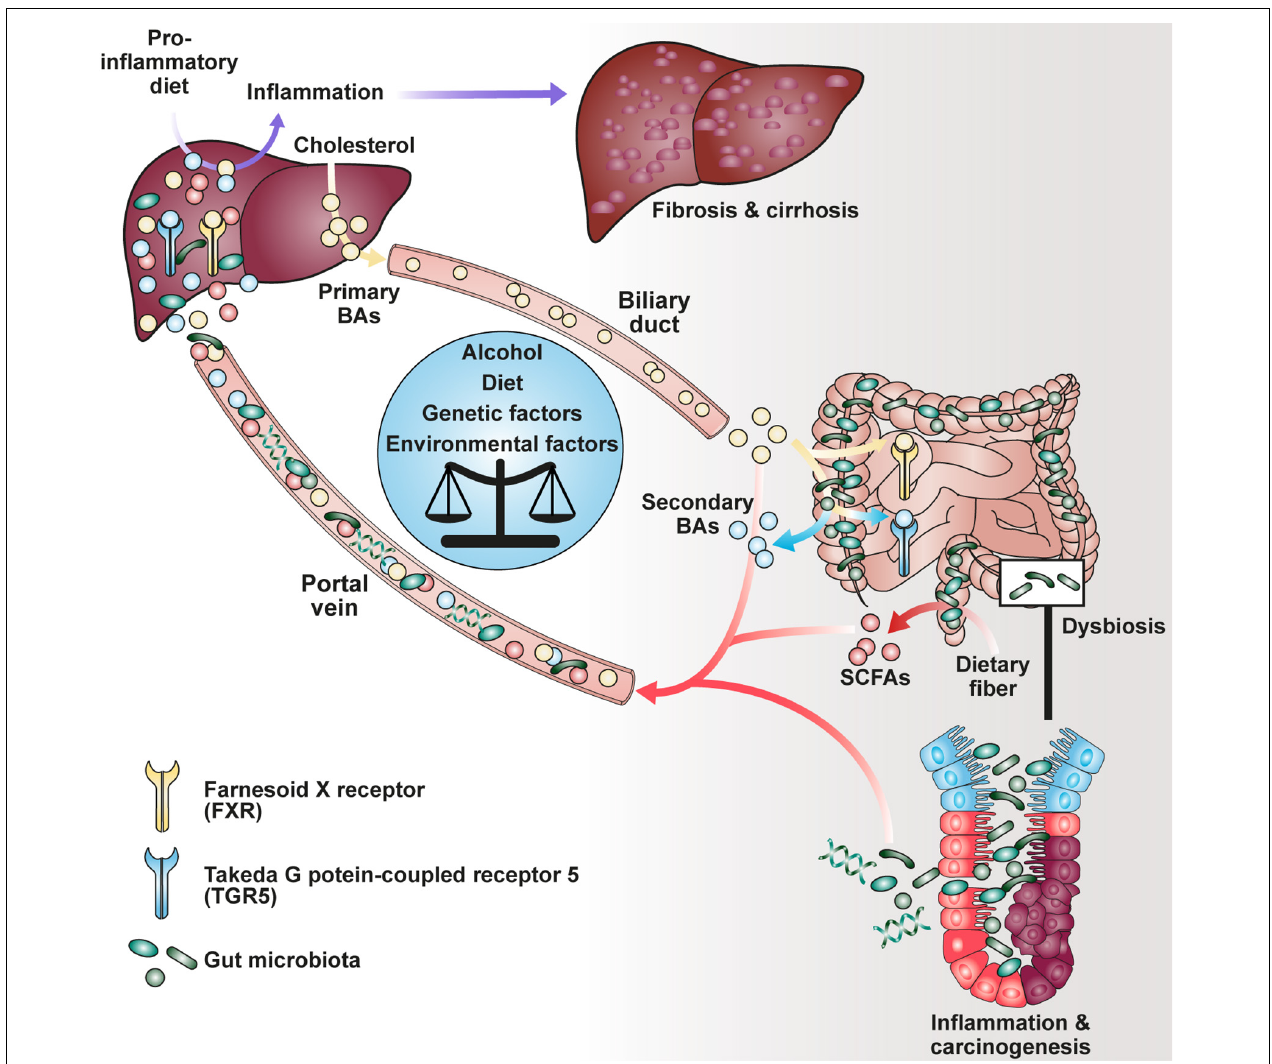
FIGURE 1 | Impact of BAs and SCFAs on the